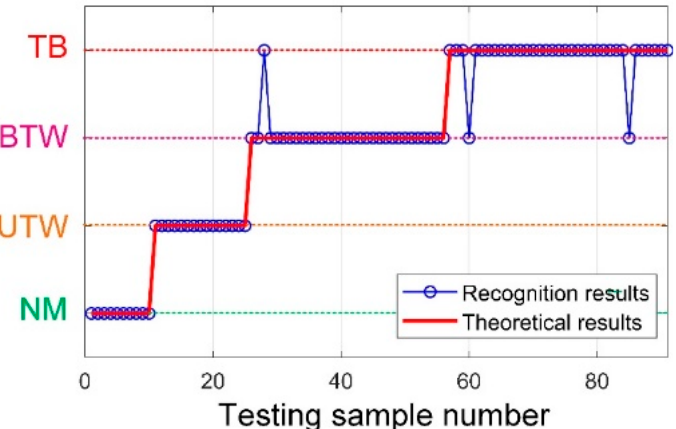
Figure 28. RPD: fault diagnosis results.